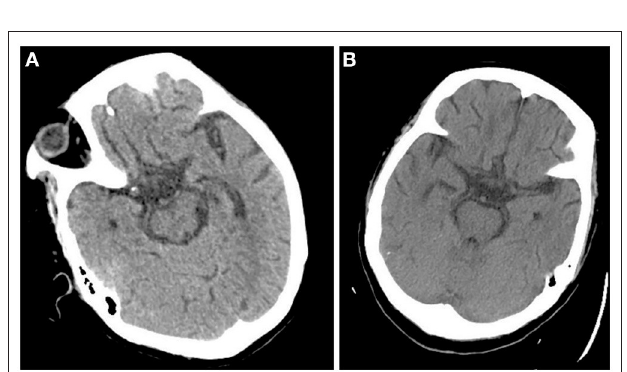
FIGURE 3 | CT scan didn’t demonstrate any hypodensity in pons 1 day after the operation (A) and 7 days after the operation (B)